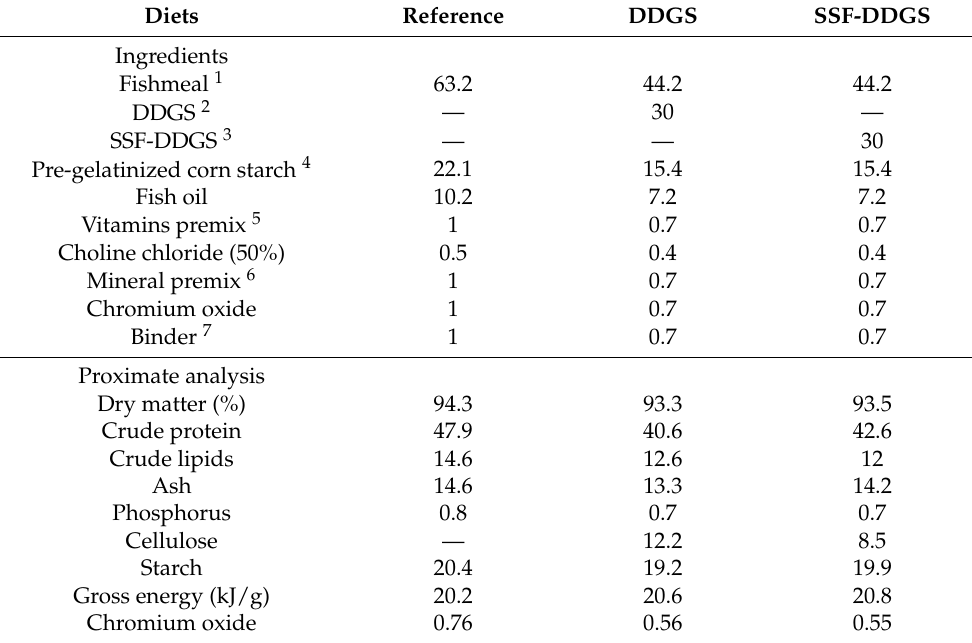
Table 2. Ingredient composition and proximate composition (% dry matter) of experimental diets.